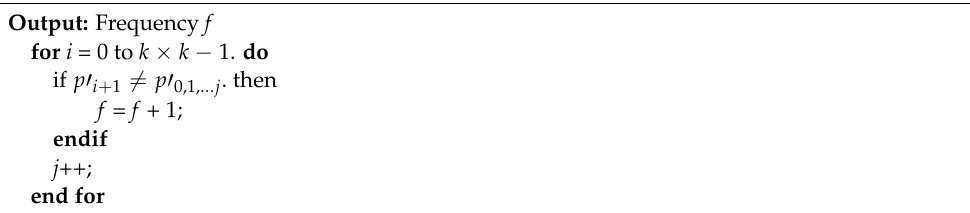
Algorithm 2. Procedure for calculating the